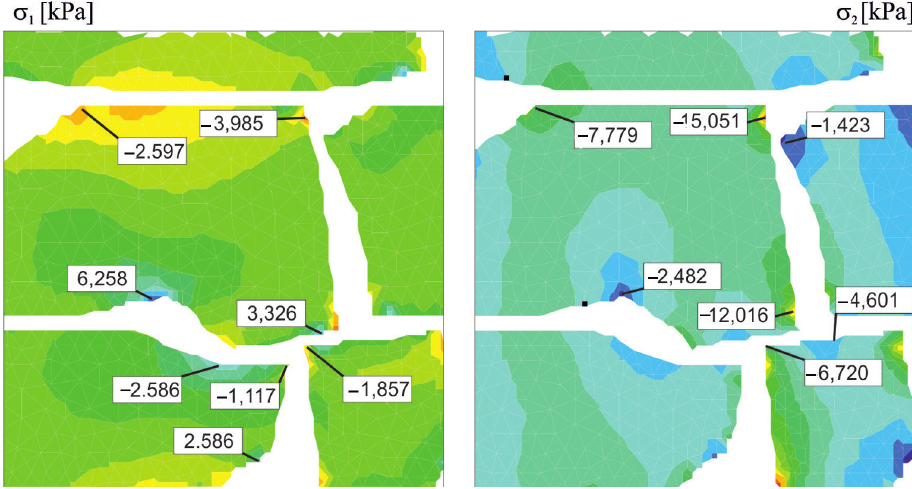
Fig. 1. Local stress concentrations around the edges of masonry units (modulus of elasticity of mortar E m = 1000 MPa, modulus of elasticity of sandstone E p = 10 000 MPa; principal stresses in mortar are not plotted for better clarity)